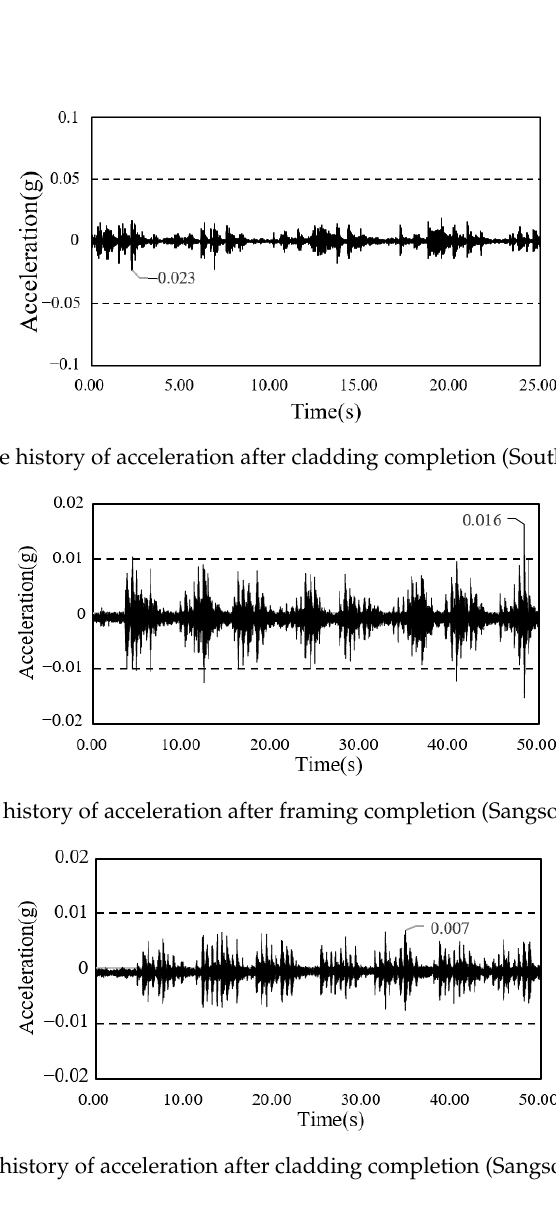
Figure 14. Time history of acceleration after framing completion (South-North church).